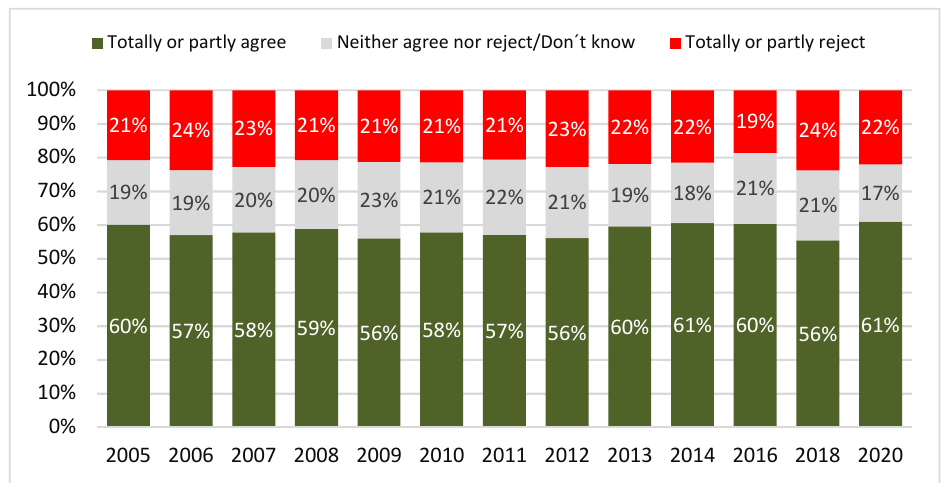
Figure 8. Positive statement about preservation of native language: It is good that all people with foreign background who come to Sweden keep their native language and teach their children the language.